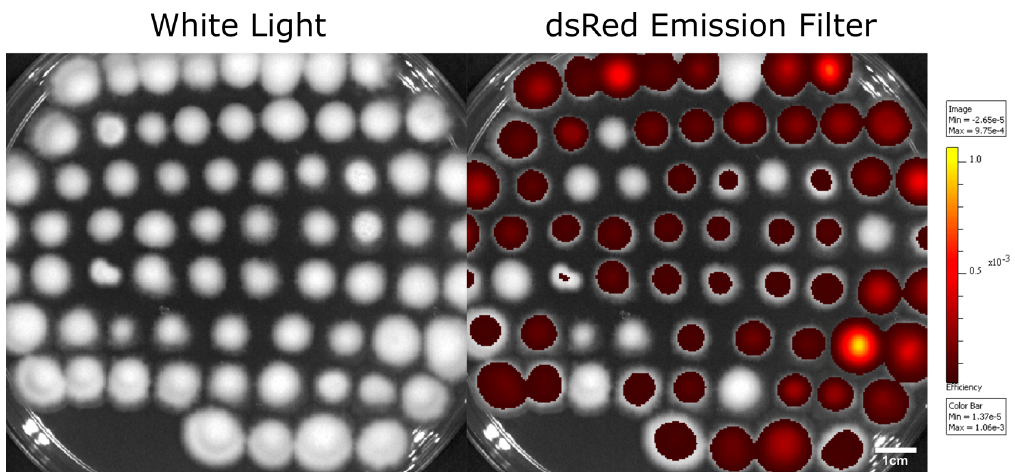
Figure 3 ‒ Macroscopic evaluation of far-red Kat-fluorescence. Fifty-eight of sixty-nine mutants evaluated displayed the far-red Kat-fluorescence (84 %). The parameters on Living Image 3.1 (implemented in the IVIS Lumina II equipment) were set to 60 second exposure time, excitation at 535 nm and 465 nm (for background removal), using the dsRed emission filter. Left Panel, White Light. Right Panel, dsRed emission